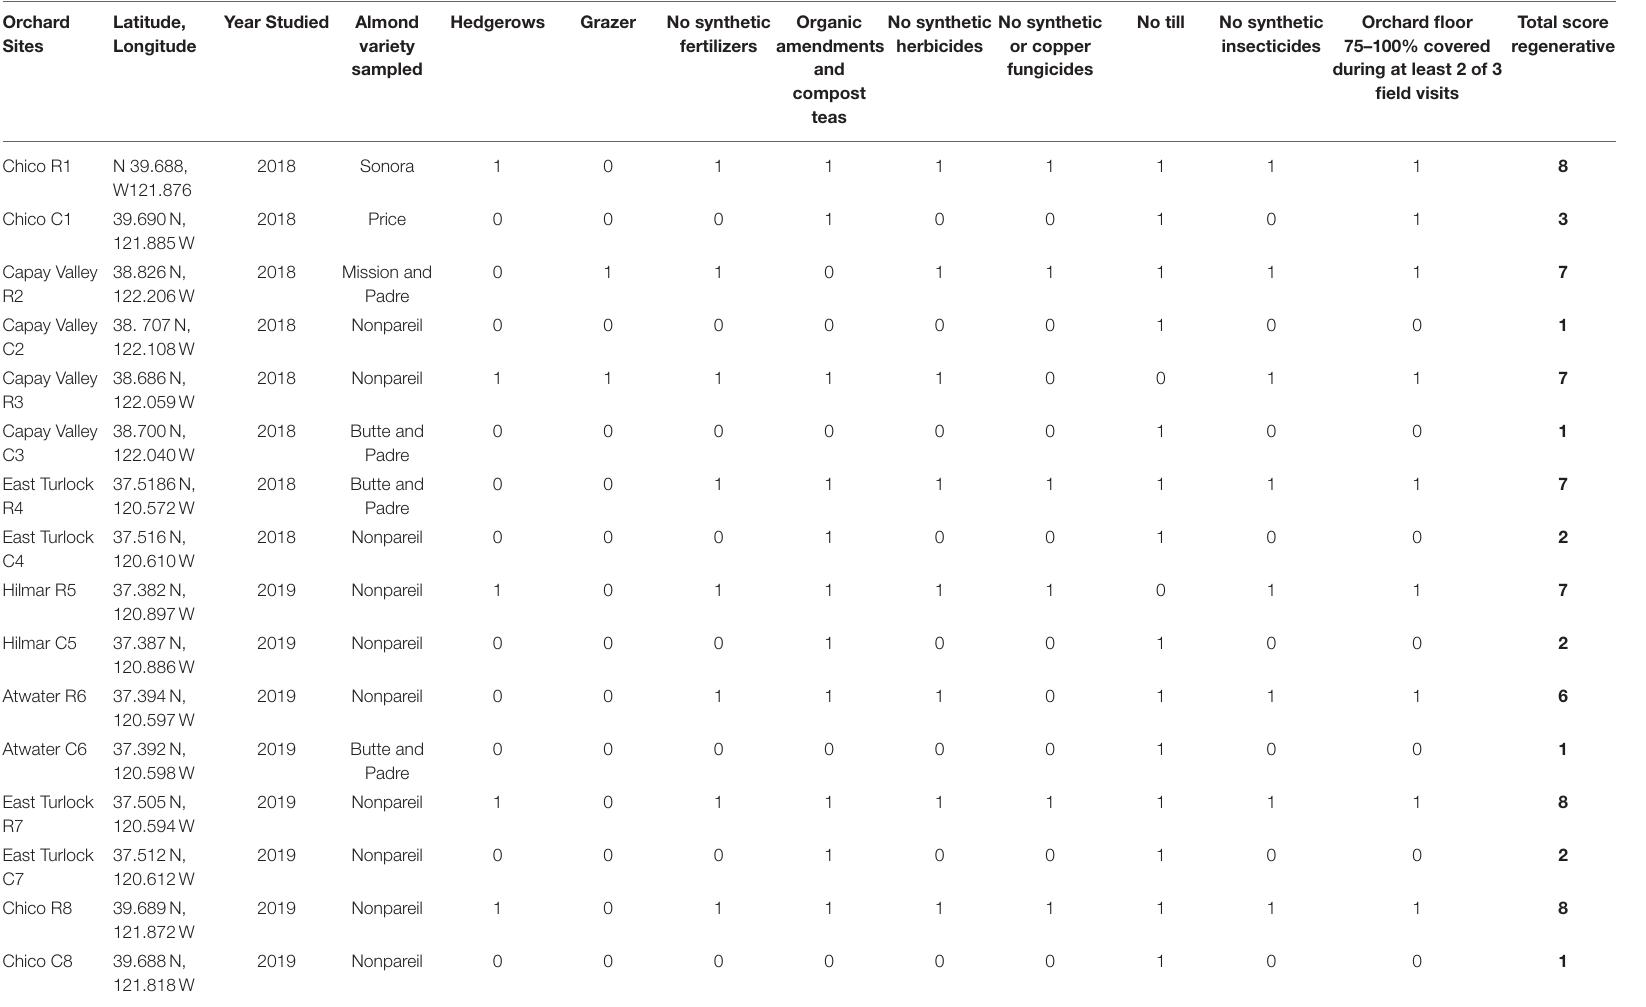
TABLE 1 | The regenerative matrix score is the sum of regenerative practices on each farm, as determined through grower surveys. Orchard